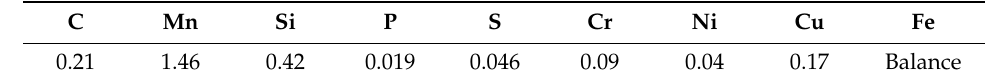
Table 2. Chemical composition of S355 steel (wt.%).